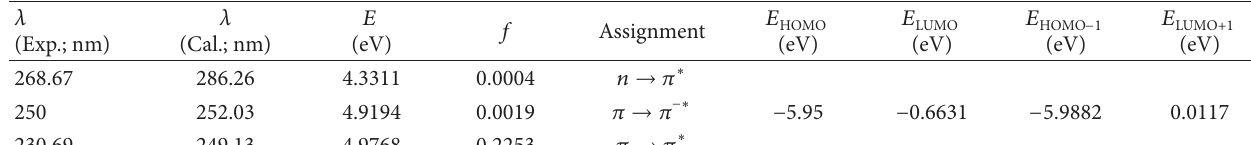
T 3: Experimental and calculated absorption wavelength ( ), and frontier orbital energies of tenofovir by TD-DFT method.